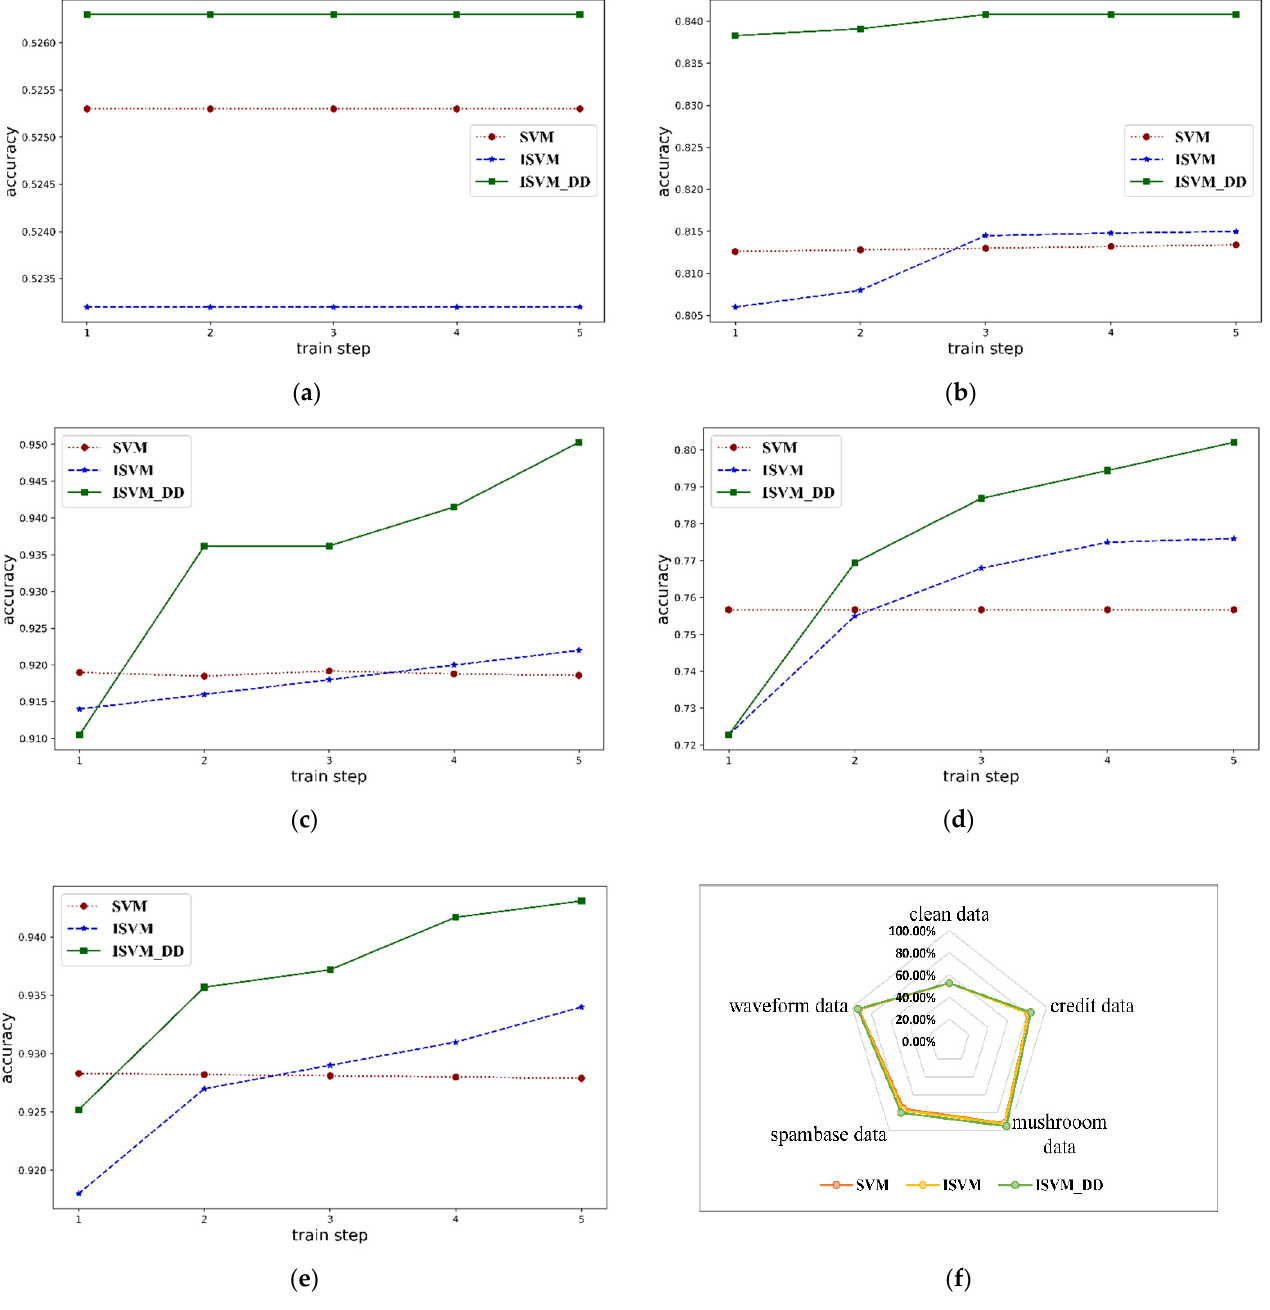
Figure 3. Comparison of the average test accuracy on five real datasets and the radar chart. ( a ) is clean data, ( b ) is credit data, ( c ) is mushroom data, ( d ) is spambase data, ( e ) is waveform data, and ( f ) is radar charts on five datasets. Table 9. Result of algorithms on five datasets.